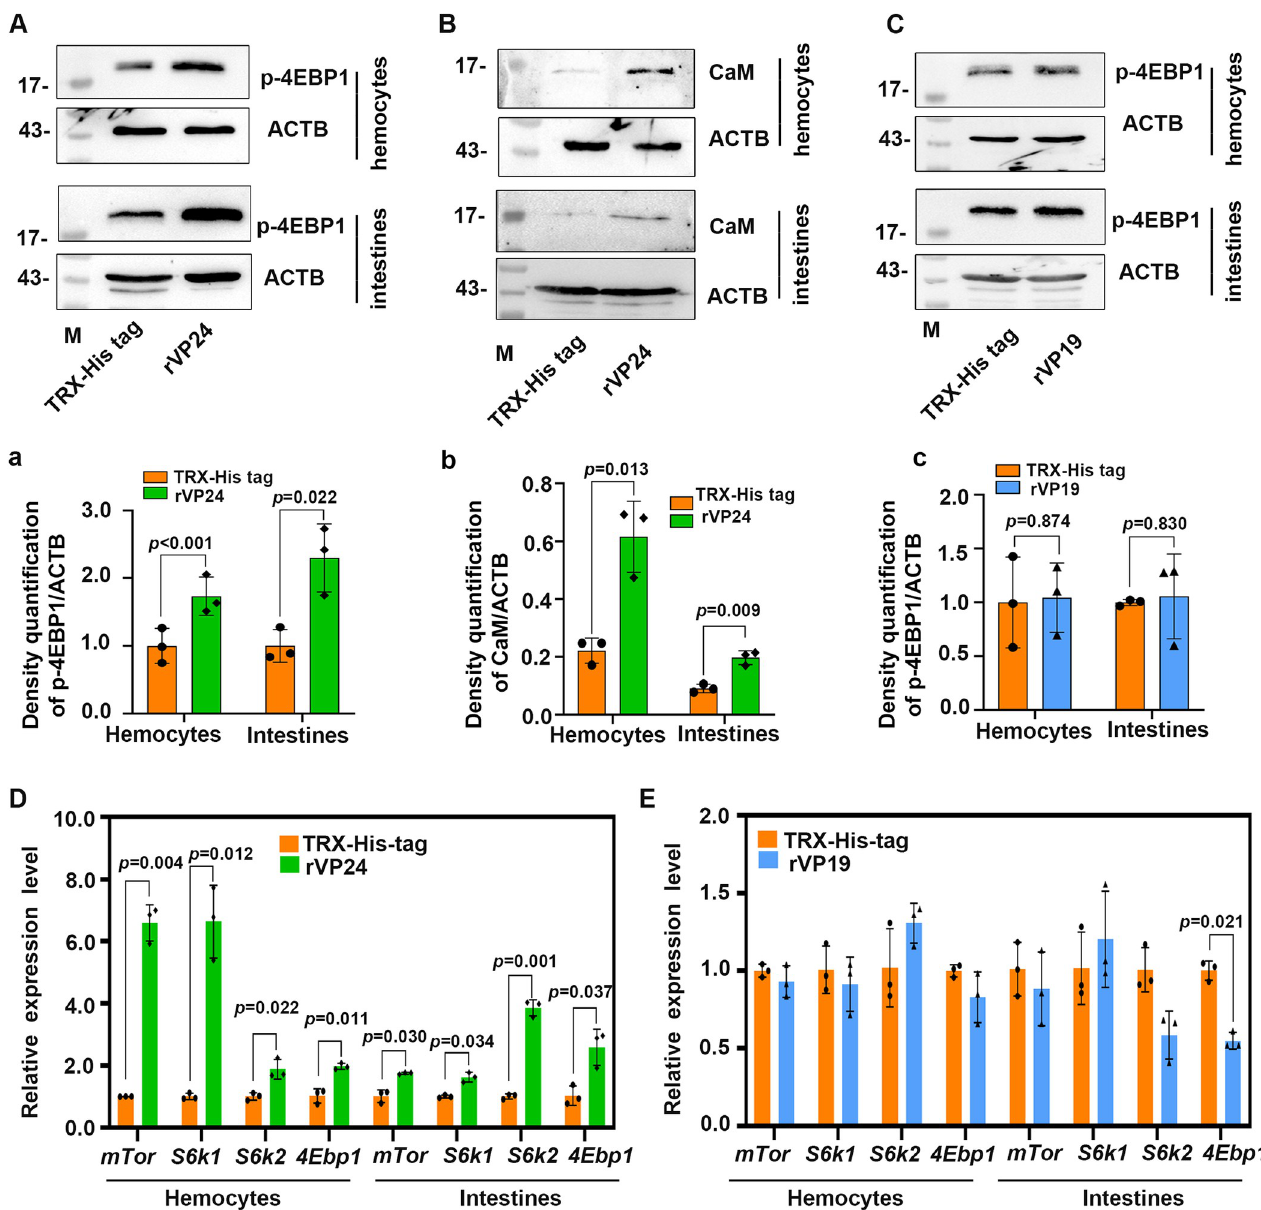
Fig 6. Recombinant VP24 can activate mTORC1 signaling via interacting with pIgR. ( A ) The phosphorylation of 4EBP1 in the hemocytes and intestines of shrimp injected with rVP24 or TRX-His tag analyzed by Western blot at 24 h post protein injection; ( a ) Statistical analysis of panel B based on three independent experiments. ( B ) The level of CaM protein expression in the hemocytes and intestines of shrimp injected with rVP24 or TRX-His tag analyzed by Western blot at 24hpi; ( b ) Statistical analysis of panel B based on three independent experiments. ( C ) The level of 4EBP1 phosphorylation in the hemocytes and intestines of shrimp injected with rVP19 or TRX-His tag analyzed by Western blot at 24 hpi; ( c ) Statistical analysis of panel C based on three independent experiments. ( D and E ) The relative expression level of mTor , S6k1 , S6k2 , and 4Ebp1 mRNA in the hemocytes and intestines of shrimp injected with rVP24 (D) or rVP19 (E) compared with the control group (TRX-His-tag) analyzed by qPCR at 24 hpi. Significant differences were analyzed using a Student’s t -test, and P < 0.05 was considered to indicate a significant